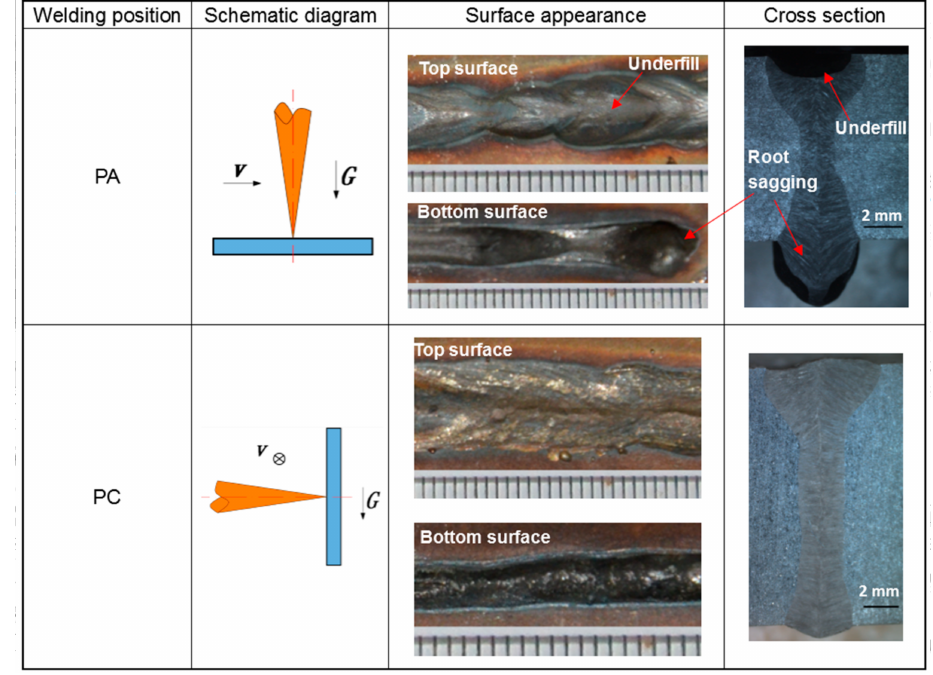
Figure 11. Effect of welding positions on the weld appearance (p = 10 kW, v = 1.2 m/min, ∆ = +10 mm, q = 20